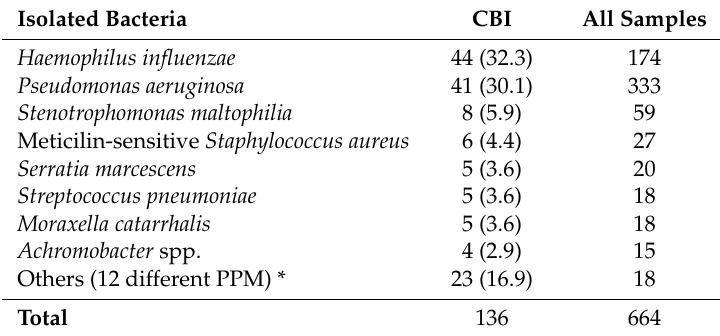
Table 2. CBI-associated